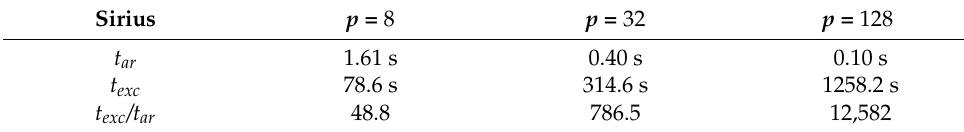
Table 2. Time spent transitions to new integer time slices for the Sirius multiprocessor system. Sirius p = 8 p = 32